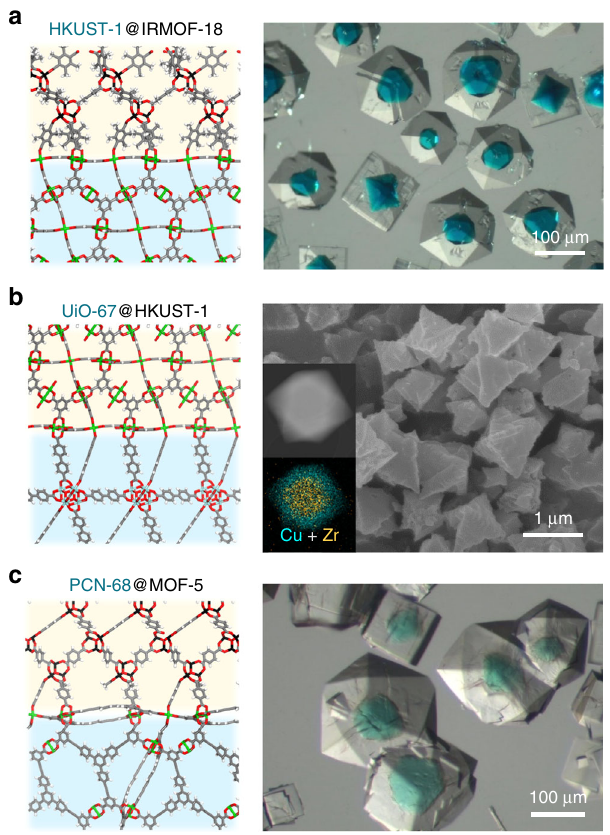
Fig. 4 Examples of synthesized cubic/cubic MOF@MOFs. a Computational structural model from matching the (111) plane and the corresponding optical image of HKUST-1@IRMOF-18. b Computational structural model from matching the (111) plane and the SEM image of UiO-67@HKUST-1. Inset is STEM image of UiO-67@HKUST-1 and corresponding overlay mapping of two elements, Zr(orange) and Cu(Cyan), based on EDS. c Computational structural model matching the (111) plane and the optical image of PCN-68@MOF-5. In a , b and c , the yellow region indicates the space for IRMOF-18, HKUST-1 and MOF-5, respectively and the green region indicates the space for HKUST-1, UiO-67 and PCN-68,